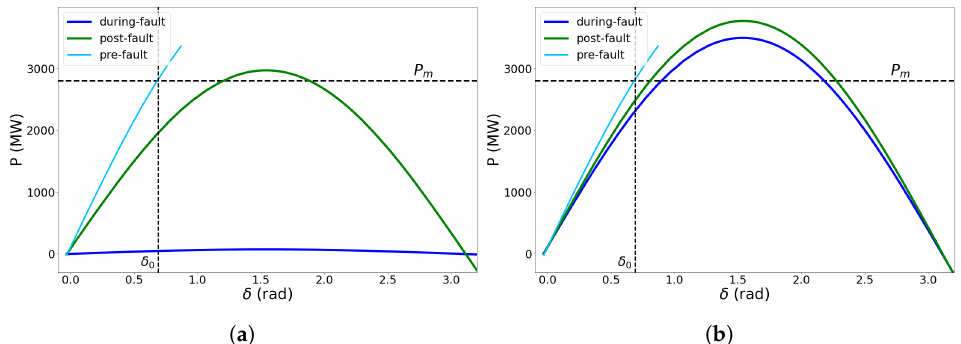
Figure 11. Exceptional case: ( a ) the sum of the areas is always positive and ( b ) system is always